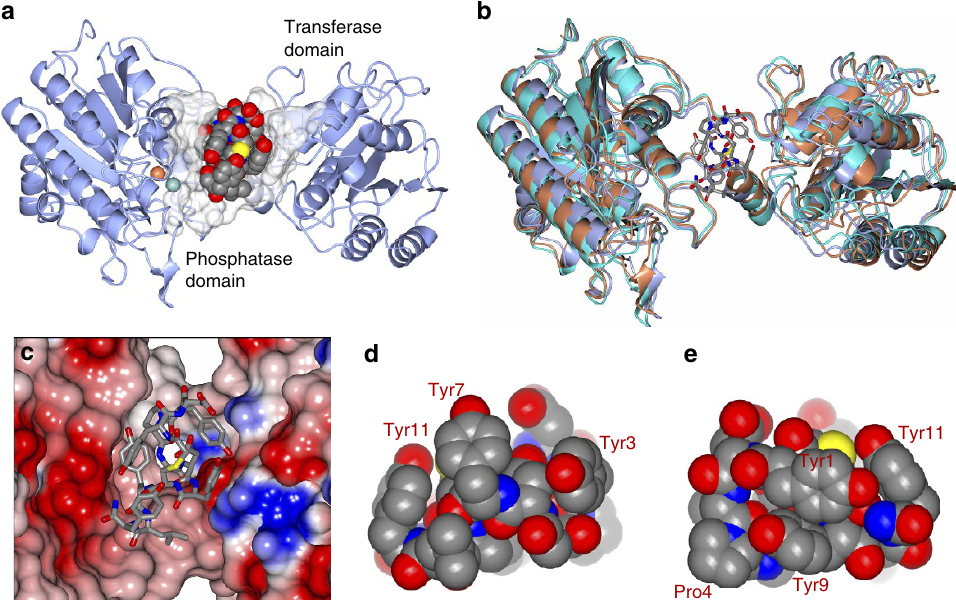
Figure 3 | Ce-2d traps iPGM in an open conformation. ( a ) One subunit of the asymmetric unit showing the binding mode of the Ce-2d macrocycle to C. elegans iPGM. The Mn 2 þ and Zn 2 þ ions are represented as blue and tan spheres, respectively, and the bound macrocycle is drawn as CPK space-filling spheres in a cavity defined by iPGM residues within 5Å (transparent spheres). ( b ) Superposition of C. elegans iPGM-o (cyan), C. elegans iPGM-m (tan) and C. elegans iPGM (cid:3) Ce-2d (aquamarine). The Ce-2d peptide is represented as cylinders. ( c ) Macrocycle (cylinders) positioned within a cleft of iPGM represented as an electrostatic surface. ( d ) CPK space-filling representations of Ce-2d illustrating the ‘capping’ orientation of the five tyrosine residues (1, 3, 7, 9 and 11) and ( e ) the edge-to-face interaction of Tyr 1 and 9. Additional residues are